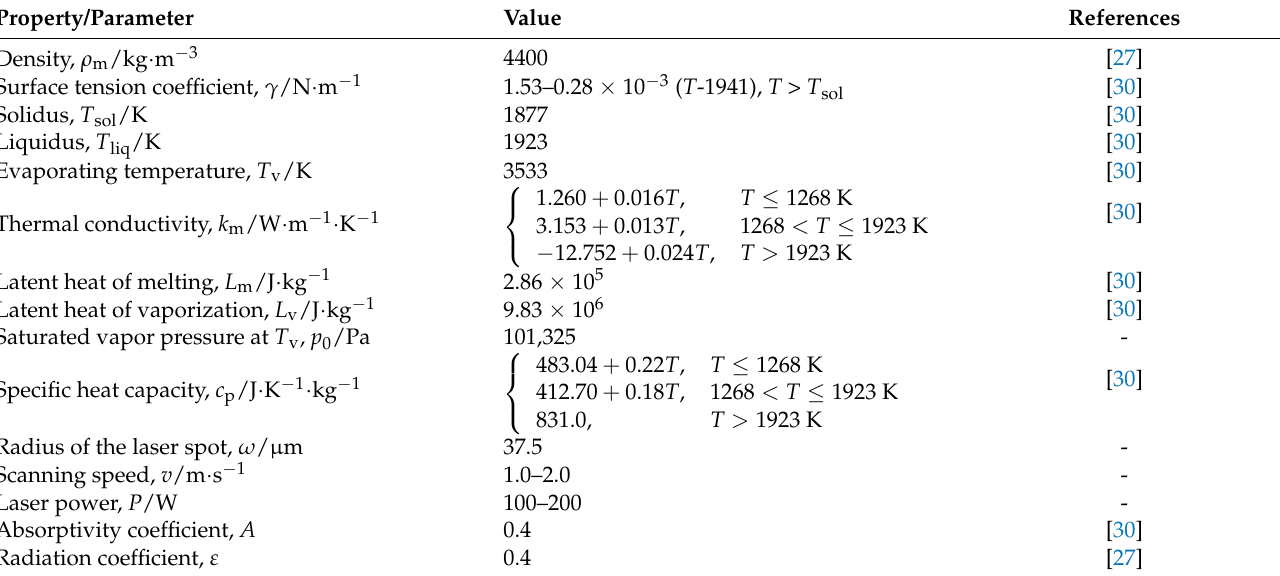
Table 1. Properties of Ti-6Al-4V and processing